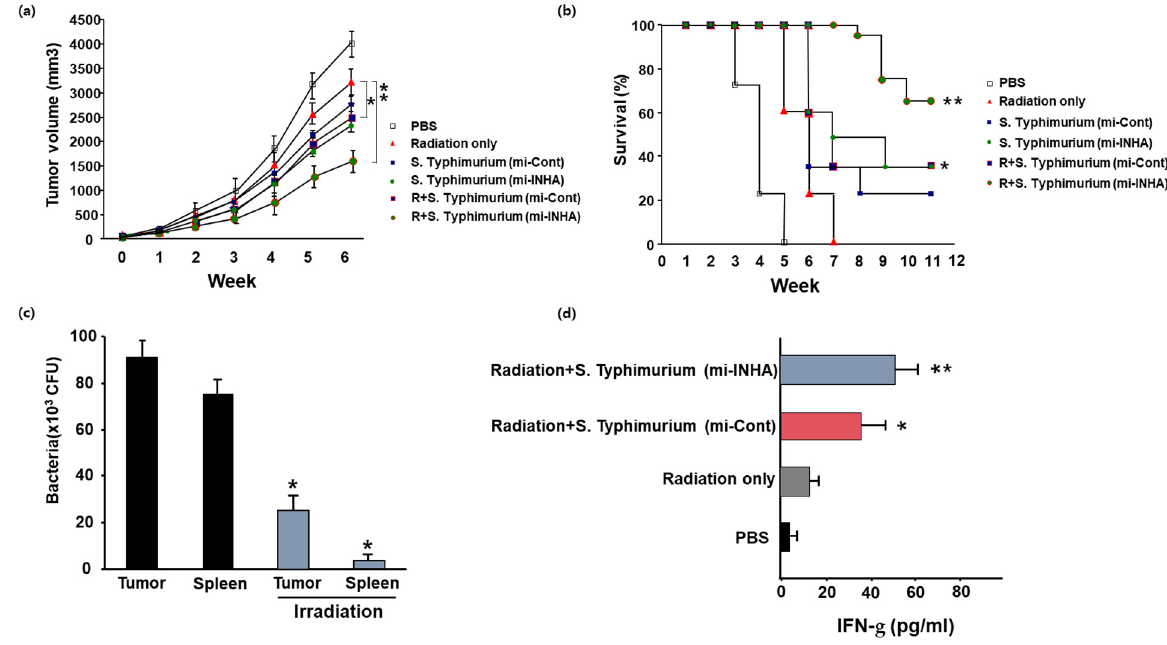
Figure 4. Effects of combined bacterial therapy with radiation in mice bearing melanoma. C57BL/6 mice bearing were inoculated s.c. on days 1 with PBS or with 1 × 10 8 CFU of attenuated unmodified S. Typhimurium , S. Typhimurium /mi-Cont, or S. Typhimurium /mi-INHA. After s.c. inoculation of bacterial cells. The mice were exposed to γ -radiation (8 Gy) on day 2 ( a ) The tumor volume was measured for up to 6 weeks after combined treatment with bacterial cells and irradiation. Data are presented as the mean ± SEM of three independent experiments. ( b ) The survival rates of all groups were recorded for up to 12 weeks. The data are presented as Kaplan–Meier survival curves, and comparisons were made using the log-rank test. ( c ) Bacterial distribution was examined in mice after s.c. inoculations with 1 × 10 7 bacterial cells. At 5 days, bacteria were not cultivated from tissue in mice with subcutaneous recombinant Salmonella inoculation. ( d ) Interferon gamma expressions were induced in mice treated with S. Typhimurium expressing IFN-g. Mice were treated with PBS and 1 × 10 8 bacterial groups. Serum was collected 7 days after inoculation and were analyzed with ELISA. p -values in figures are indicated with asterisks (*; p < 0.05, **; p < 0.01).